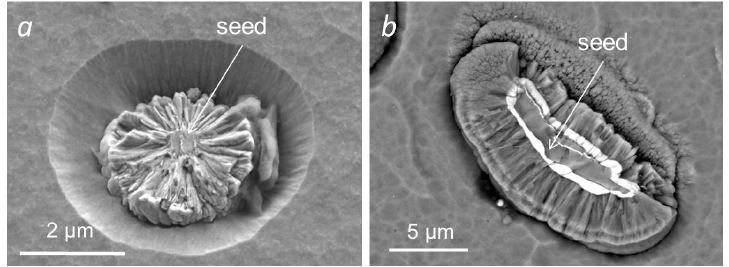
Figure 13. SEM micrographs of two broken nodular defects in TiAlN hard coating sputter-deposited on D2 tool steel substrate.